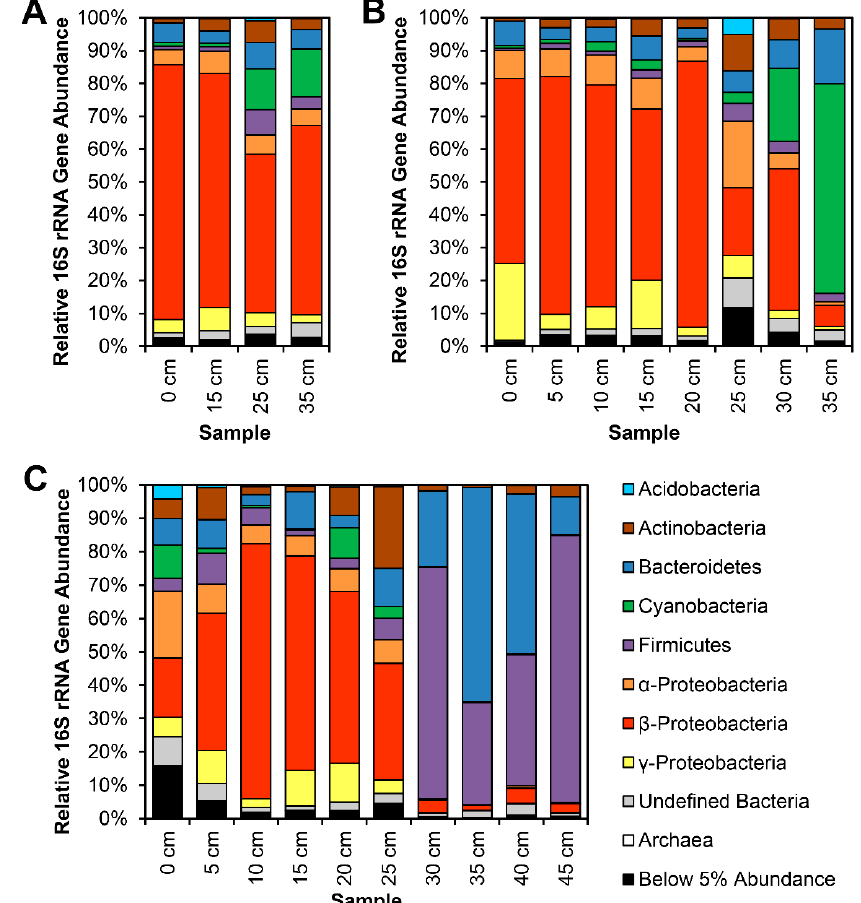
Figure 3. Phylum- and Proteobacterial class-level 16S rRNA gene relative abundances in three horizontal transects collected at Site 4: ( A ) 35 cm transect collected at Spring A in April 2014. ( B ) 35 cm transect collected at Spring B in April 2014. ( C ) 45 cm transect collected at Spring A in July 2014. Transects started inland at each spring seep, ca. 15 cm from the waterline. Samples were collected from the top layer of soil (on land) or upper layer of sediment (in the canal water column).